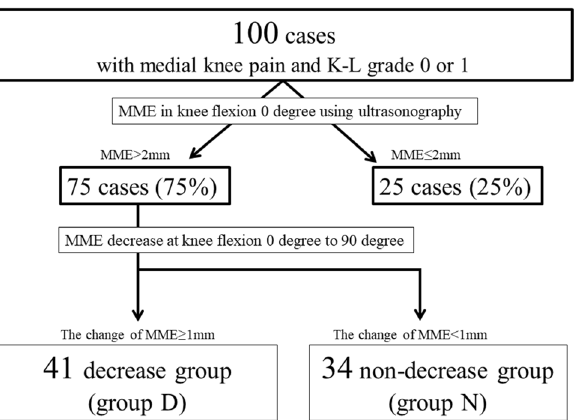
Figure 2. The flow chart of inclusion criteria and grouping in this study. MME medial meniscal